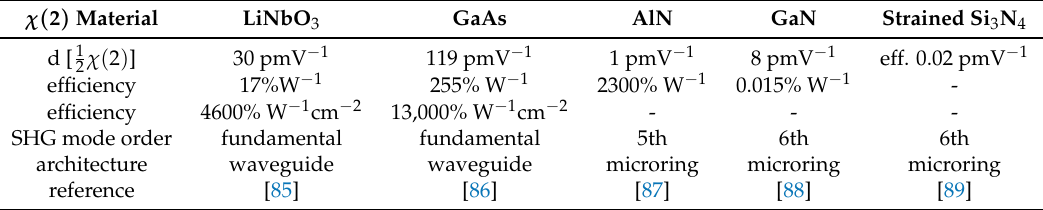
Table 4. Second-harmonic generation in integrated